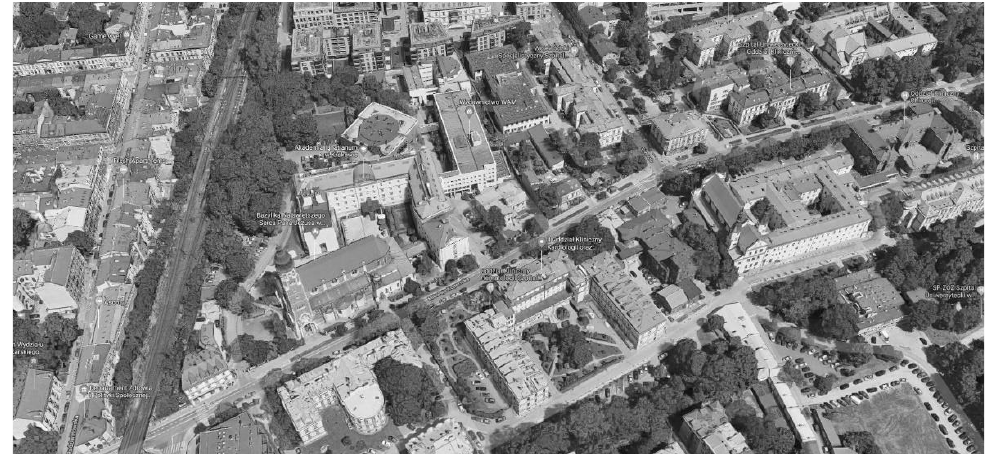
Figure 3. Cluster/campus layout: former clinical hospital in Kraków. Source: www.google.pl/maps (accessed on 1 September 2021).